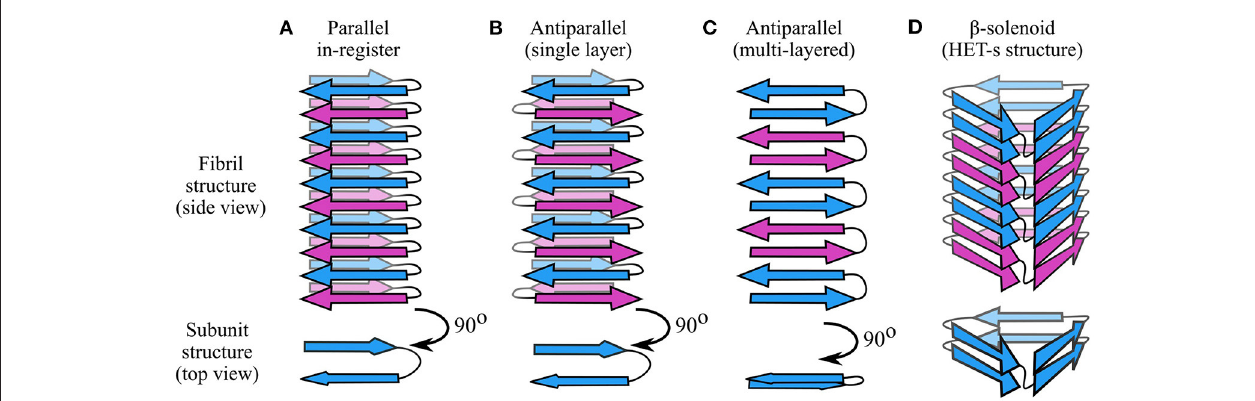
FIGURE 3 | Types of cross- β structures. (A) In parallel in-register structures, each subunit contributes a single strand per intermolecular β -sheet, and the strands are oriented parallel and in-register with one another. Thus, the hairpin-like structure shown in this figure has two intermolecular β -sheets. (B) In single-layered antiparallel cross- β structures, each subunit contributes a single β -strand per β -sheet, but the strand direction alternates. (C) In multi-layered antiparallel structures, each subunit contributes more than one strand per β -sheet. (D) In β -solenoids such as HET-s (Wasmer et al., 2008), subunits occupy more than one layer by coiling in a solenoidal fashion. In these schematics, adjacent subunits are alternately colored blue and purple. Each monomeric subunit in the parallel in-register and antiparallel structures is a two-strand hairpin, differing only in orientation of the strands; a different monomer structure is used for the β -solenoid, based on a simplification of the HET-s structure (Wasmer et al.,